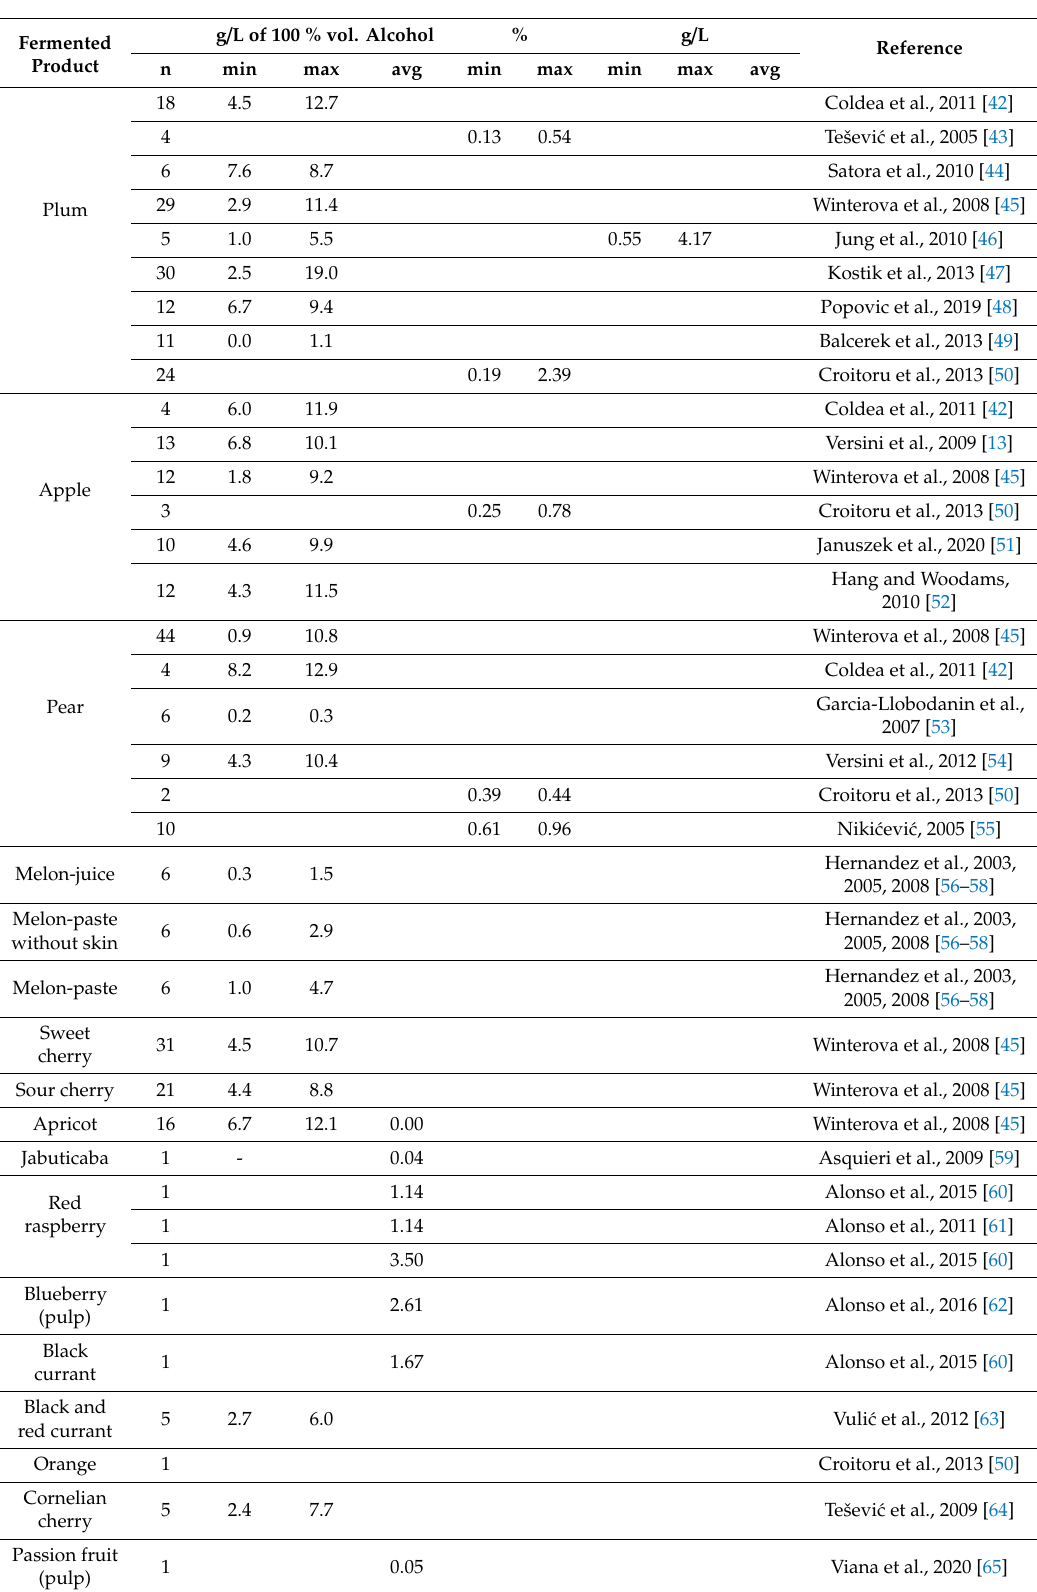
Table 3. Methanol contents (in grams per liter of 100% vol. alcohol, % and g per liter) found in several fruit spirits (n-number of samples analyzed; min-minimum value; max-maximum value; avg—average result). g / L of 100 % vol. Fermented Product